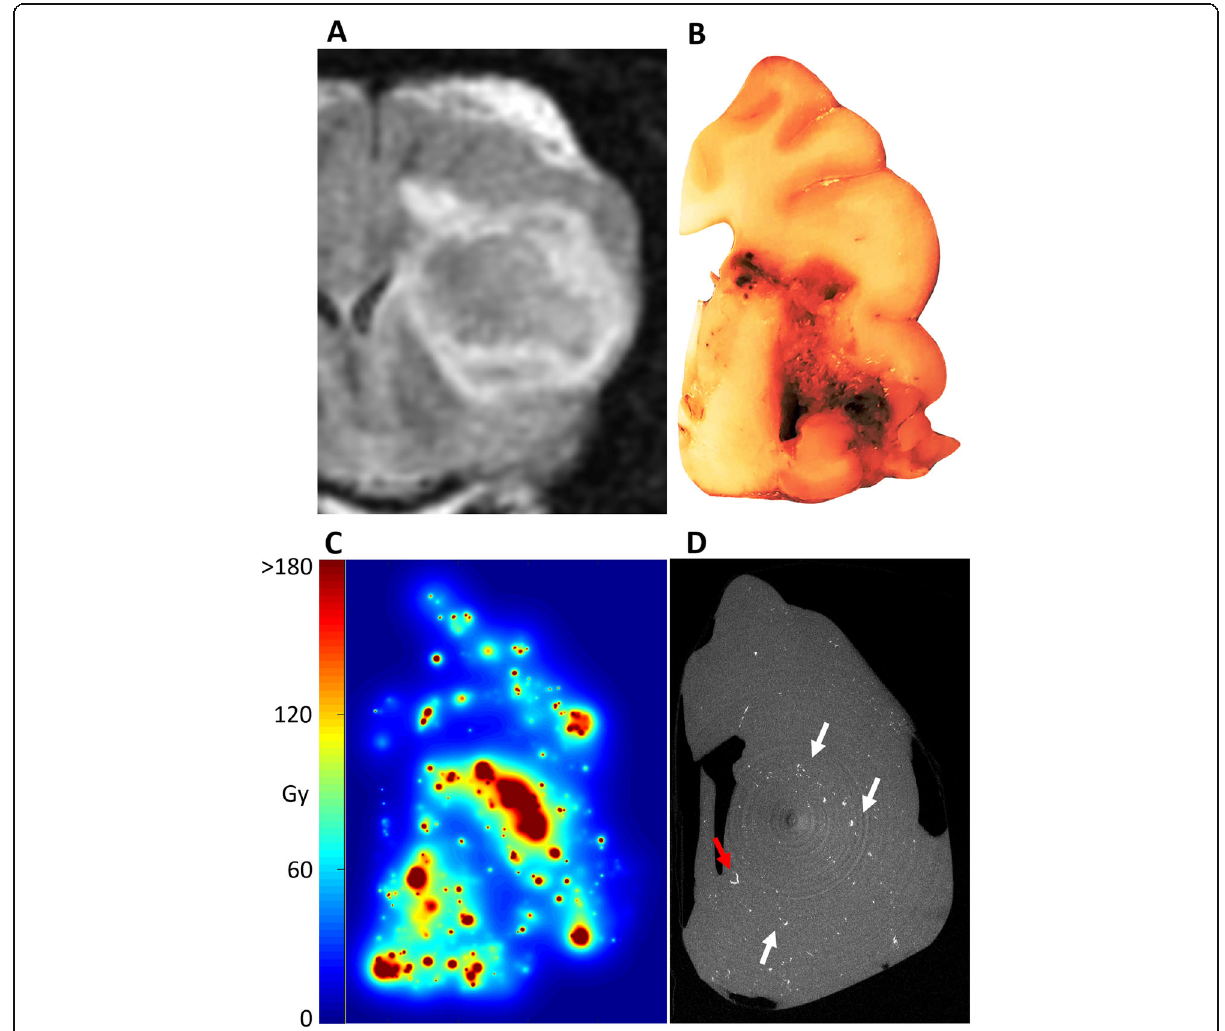
Fig. 7 Gross pathology and microdosimetry for P5. a Pre-treatment T2 FLAIR 1 month prior to therapy. b Formalin-fixed gross pathologic example of the involved hemisphere with significant central tumor necrosis. c Microdosimetry showing the absorbed dose distribution in dog P5 if the dog had survived. At the time of death, only 15% of the absorbed doses shown had been delivered based on the half-life of 90 Y. d Post-explant microCT showing the gross distribution of glass microspheres. the image is a maximum intensity projection of 100 microCT slices with a combined thickness of 900 μ m. A preference for deposition in the peri-necrotic region of the tumor can be seen (white arrows). Occasional filling of end arterioles/capillaries with microspheres can be visualized (red